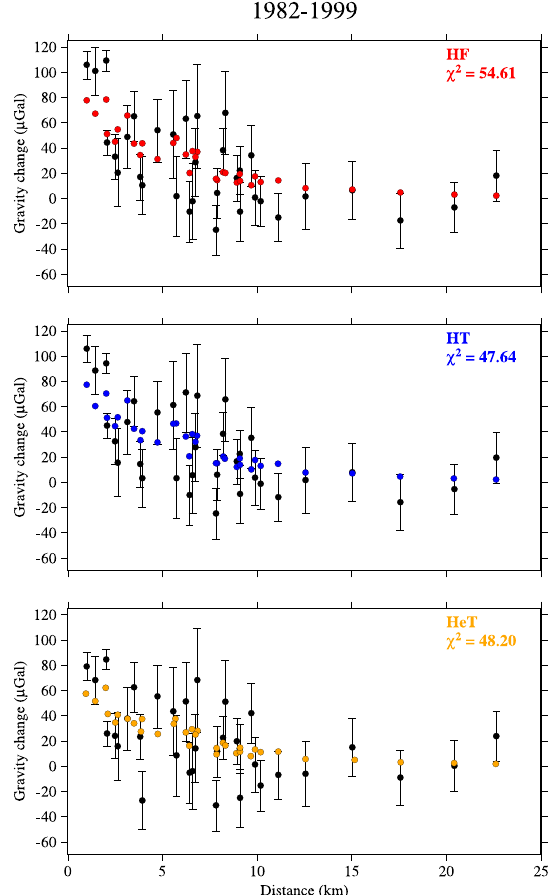
Figure 12. Comparison between observed (black circles with 1-sigma error bars) and modeled (colored circles corresponding to different model configurations) residual gravity, δ g 2 V . The misfit value χ 2 for each case is also indicated. The corresponding best fit values for density, under the assumption of incompressible magma, are shown in Table 4. HF: homogeneous crust, red circle; HT: homogeneous crust with topography, blue circle; HeT: heterogeneous crust with topography, orange circle.